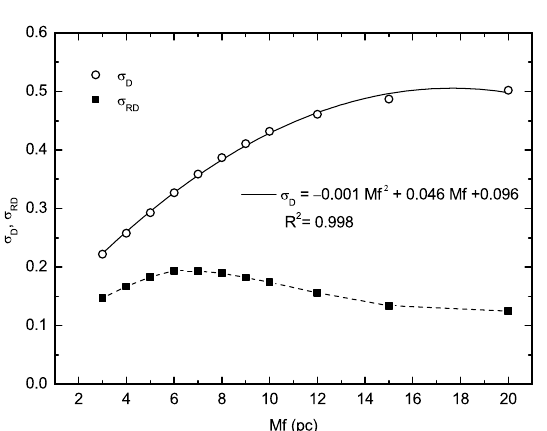
Fig. 8. Variation of the standard deviations of the D and RD values as a function of scale factor Mf .